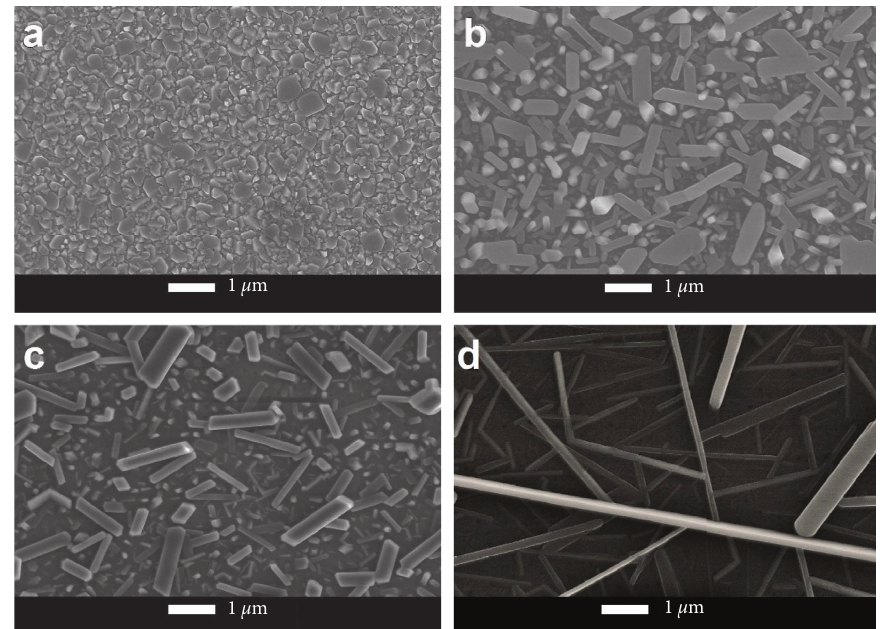
Figure 3: SEM images of the PLD VO 2 (M) films grown at different substrate temperatures: (a) 450